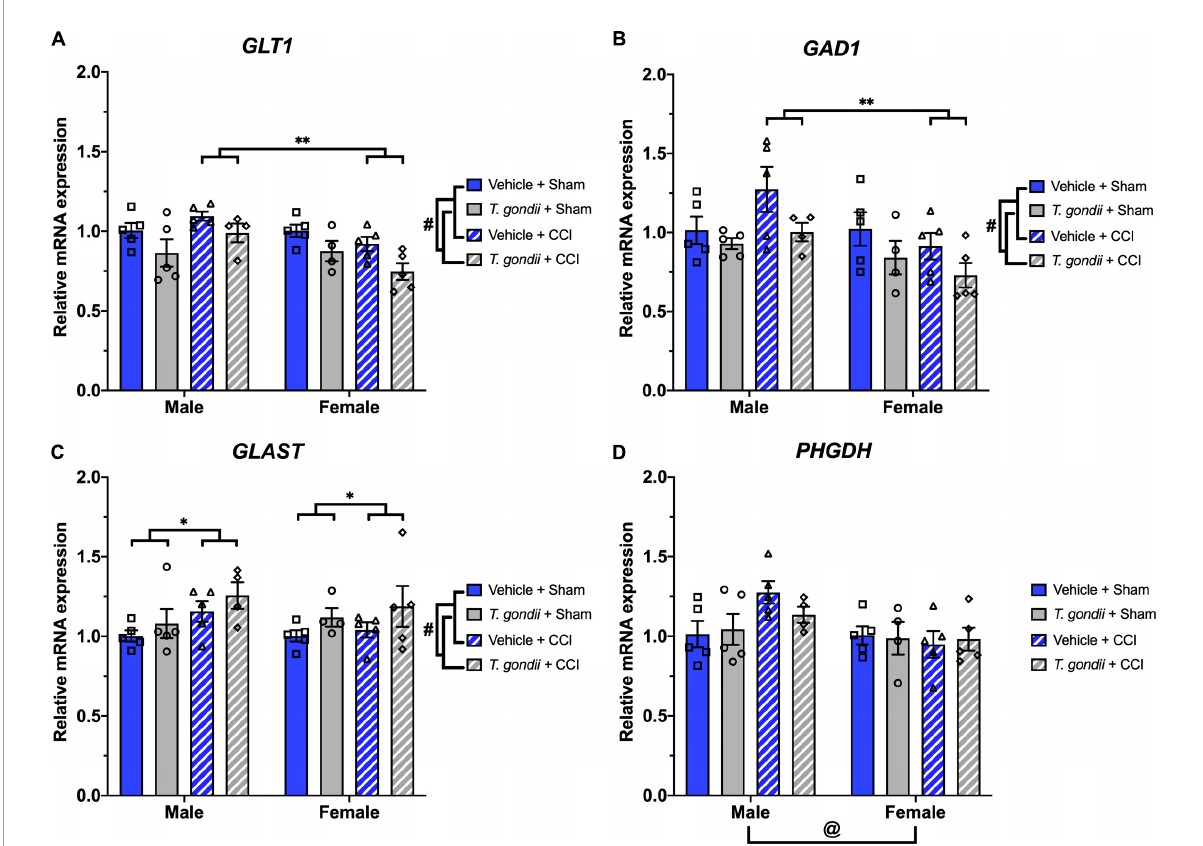
FIGURE8 Toxoplasma gondii , controlled cortical impact (CCI), and sex alter the expression of glutamate pathway components. Expression of GLT1 (A) and GAD1 (B) were decreased in T. gondii -infected and female mice compared to vehicle and male mice, respectively. CCI females had lower expression of GLT1 and GAD1 compared to CCI males. In contrast, T. gondii -infected and CCI mice had increased expression of GLAST (C) compared to vehicle and sham mice, respectively. Expression levels of PHGDH (D) were lower in female mice compared to males. # T. gondii -infected mice significantly differ from vehicle mice, ∗ sham mice significantly differ from CCI mice, @ male mice significantly differ from female mice, ∗∗ male CCI mice significantly differ from female CCI mice, p < 0.05. n = 4–5/group/sex. Data shown is mean ±